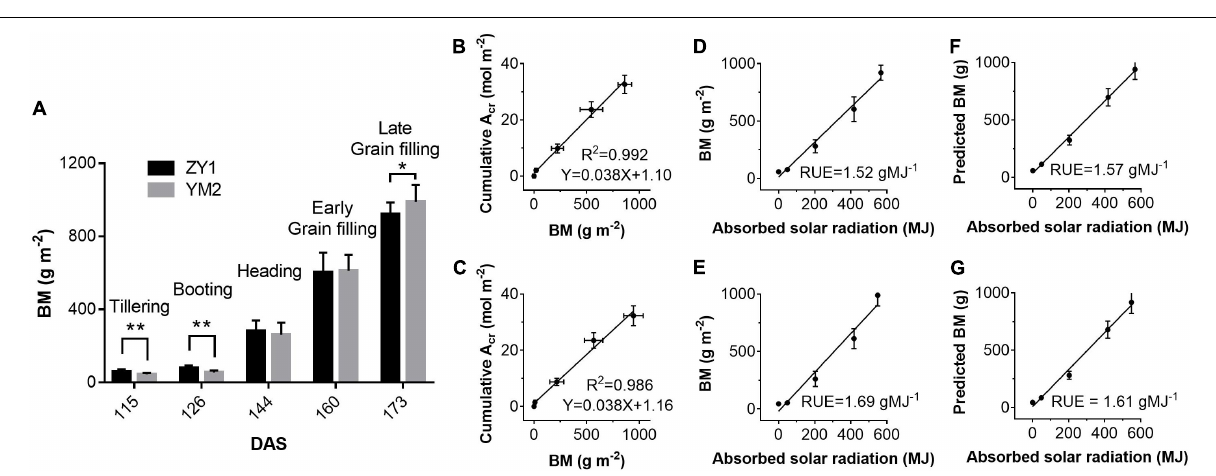
FIGURE 8 | Above-ground biomass (BM) harvested on days at different stages (A) and the correlations between BM and cumulative plant CO 2 uptake rate (A cr ) for ZY1 (B) and YM2 (C) , respectively. Relationships between measured BM and absorbed solar radiation (equals to canopy absorbed solar energy for PAR divided by 0.487) for ZY1 (D) and YM2 (E) and the relationship between predicted biomass (predicted BM) and absorbed solar radiation for ZY1 (F) and YM2 (G) were plotted. The predicted BM was calculated from net whole plant CO 2 flux measured with multi-CAPTS. RUE is the slope of linear regression of the BM vs. absorbed solar radiation and the predicted BM vs. absorbed solar radiation. Data in panel (A) are shown with mean ± SD ( n = 15) and double asterisks show p < 0.005 and single asterisks shows p < 0.05 for Students’ t -test. Data in panels (B–G) are shown with mean ± SD ( n = 3